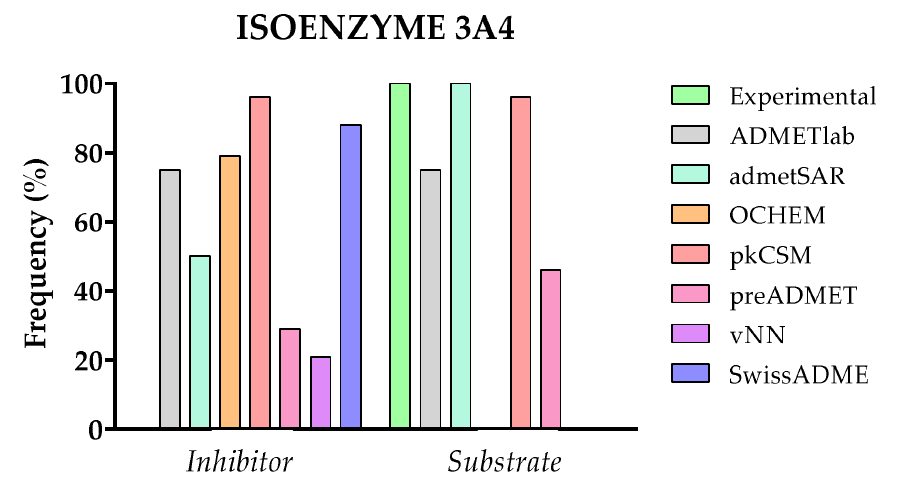
Figure 8. Comparison of experimental and predicted data between ADMETlab, admetSAR, OCHEM, pkCSM, vNN, and SwissADME for the inhibition or being a substrate of the 3A4 isoenzyme ( n =